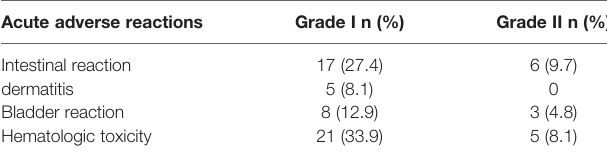
TABLE 3 | The incidences of acute adverse reactions of group